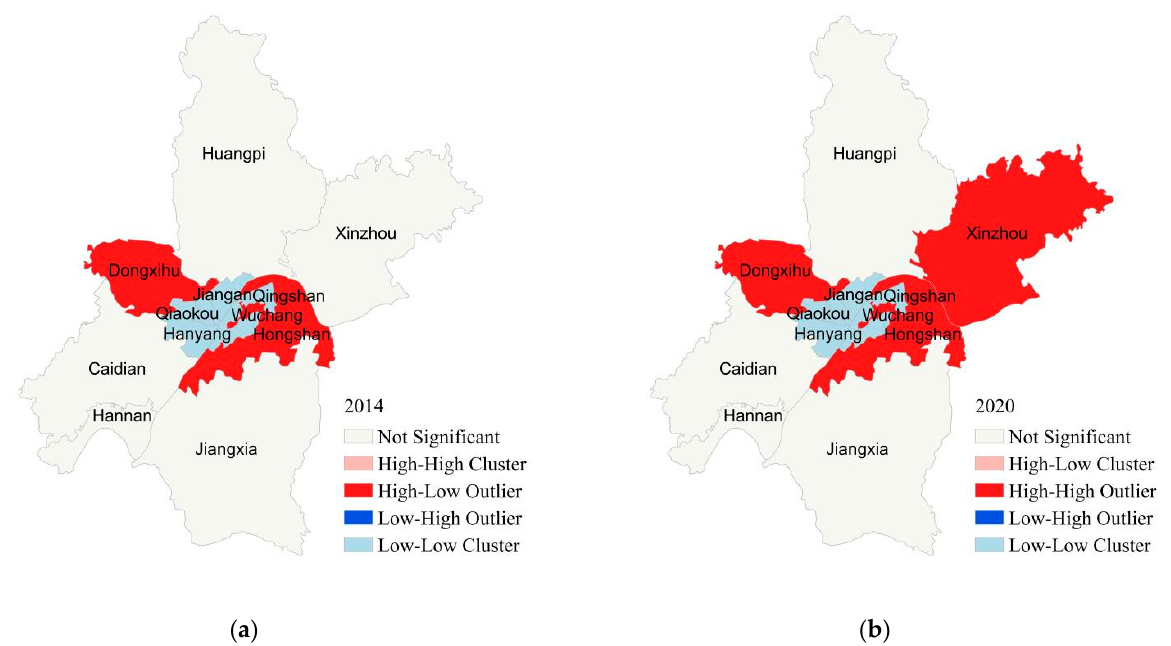
Figure 3. LISA cluster map of ecological level in Wuhan. ( a ) 2014. ( b ) 2020. According to the quartile map of Wuhan city in Figure 4, Huangpi District, Xinzhou District, and Jiangxia District in 2014 and 2015 belonged to the first ecological level, Caidian district, Hannan District, and Hongshan District belonged to the second ecological level, and Dongxihu District, Jiang’an District, and Wuchang District belonged to the third ecological level. Hankou district, Qingshan District, and Hanyang District belonged to the fourth ecological level. In 2015 and 2016, Dongxihu District rose from the third ecological level to the second ecological level. In 2016, Hannan District was briefly lowered to the third ecological level before being restored to the second ecological level in the following year. In 2015, Hongshan District was briefly reduced to the third ecological level, before being restored to the second ecological level in the following year. Firstly, in terms of the overall development of each district, the ecological level of Wuhan was generally “high in the periphery and low in the center”, which is contrary to the trend of the economic level, consistent with Krugman’s “center–periphery” theory, indicating that Wuhan is still trying to achieve the coordinated development of economy and ecology. Secondly, some of the outer districts had better ecological advantages, such as Huangpi District, Xinzhou District, Jiangxia District, Hannan District, and Caidian Dis- trict. Hongshan District features the East Lake high-technology development zone, exhib- iting ecological and geographical advantages with a high development potential.